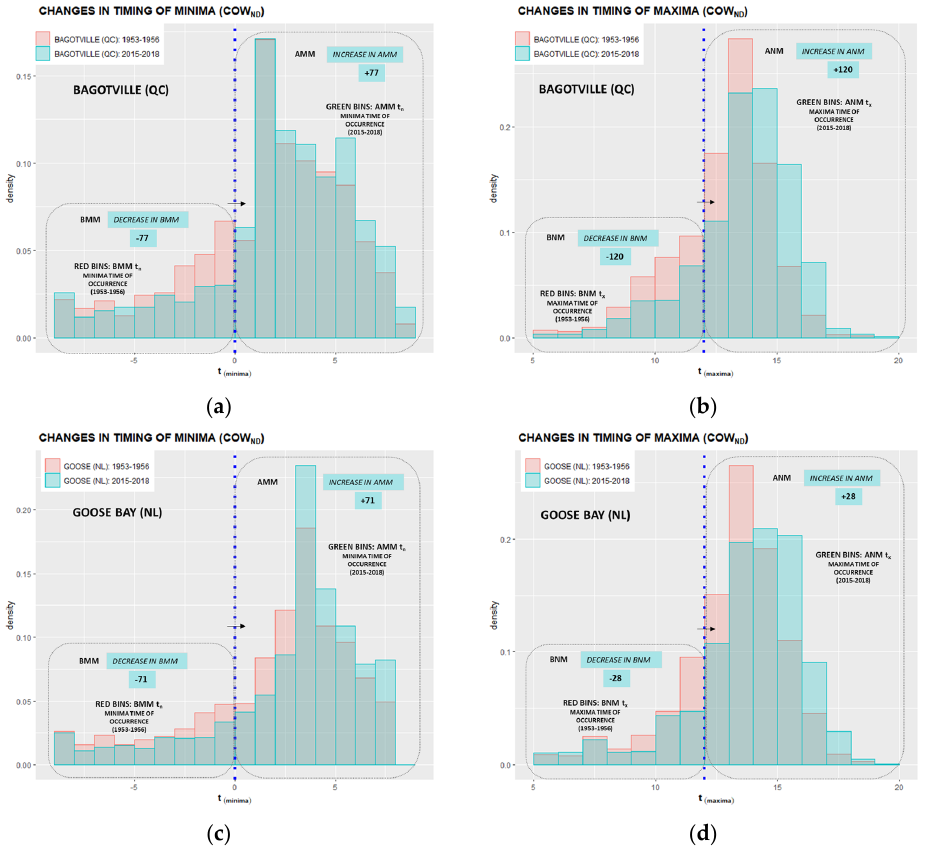
Figure A17. Northeastern Forest climate region: Bagotville (QC) and Goose (NL). Time evolution of the Diurnal Extrema Timing (DET) histograms at Bagotville ( a , b ), and Goose ( c , d ) stations. Migration of the Before Midnight Minima (BMM) to After Midnight Minima (AMM) and migration of the Before Noon Maxima (BNM) to After Noon Maxima (ANM) between four-year averages at the beginning (1953–1956) and ending (2015–2018) of data ranges. The blue dotted line represents midnight delineation ( left ) and noon delineation ( right ).